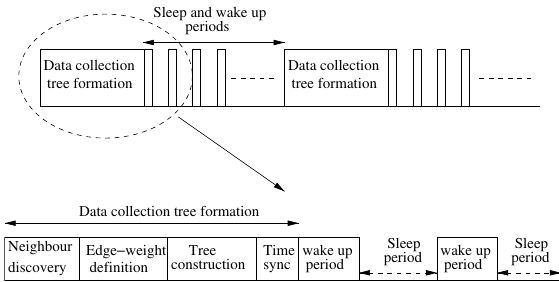
Figure 2. Sequence of operations occurring in the network To increase the lifetime of the network, the sensing nodes follow a periodic sleep and wake up schedule (see Fig. 2). The nodes are in energy saving sleep mode for most of the time in comparison with other stages (for example, one sleep period = 58 minutes, one wakeup/ active period = 2 minutes and the total time between consecutive “data collection tree formation” phases = 3 days). During the wake up period, each node senses all the parameters: soil moisture, soil temperature, atmospheric temperature and relative humidity